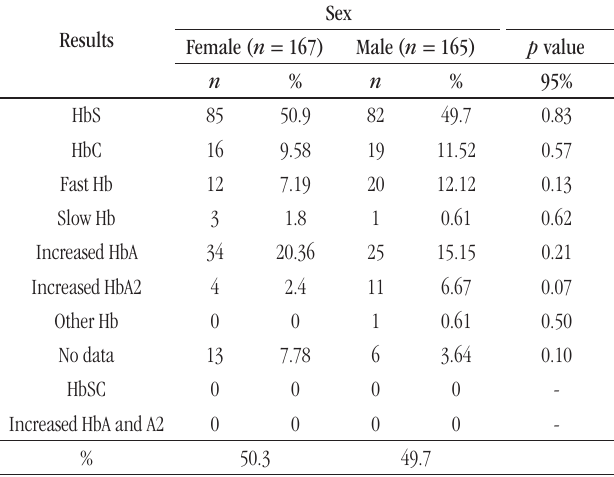
taBLE − Hemoglobinopathy frequency distribution by sex